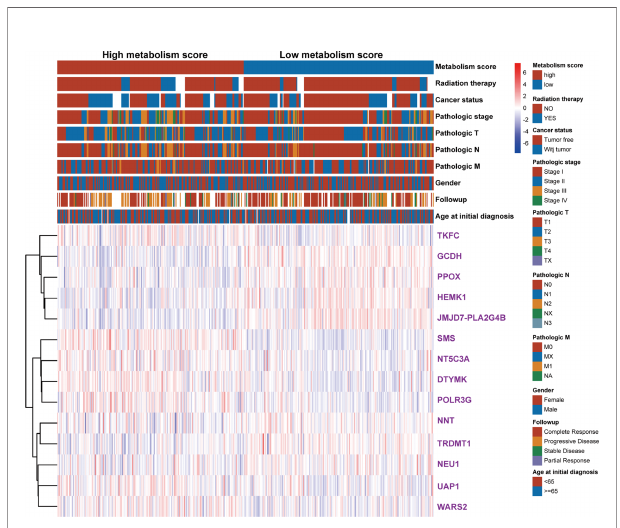
FIGURE 5 | The heat map of clinical characteristics and gene expression level between high- and low-Metabolism Score groups. LUAD specimens were divided into high- and low-Metabolism Score groups, clinical characteristics (age_at_initial_diagnosis, follow-up results, gender, pathologic_M, pathologic_N, pathologic_T, pathologic_stage, cancer_status, radiation_therapy, survival time and survival status), and 14 MRGs expression levels were